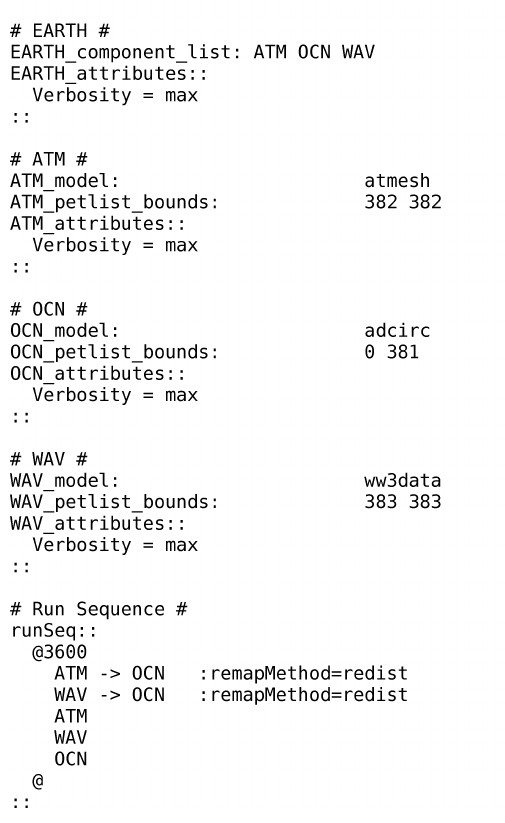
Figure 2. Coupled application configuration file. All model configurations and results are pre-decisional and for official use